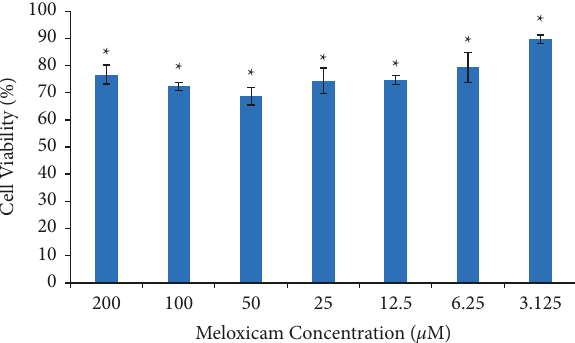
Figure 1: Raji cell viability was treated with various concentrations of meloxicam for 24 hours. A decrease in the viability of the cell as a response to meloxicam is shown. ∗ p < 0 . 05 versus Raji cells untreated (control).